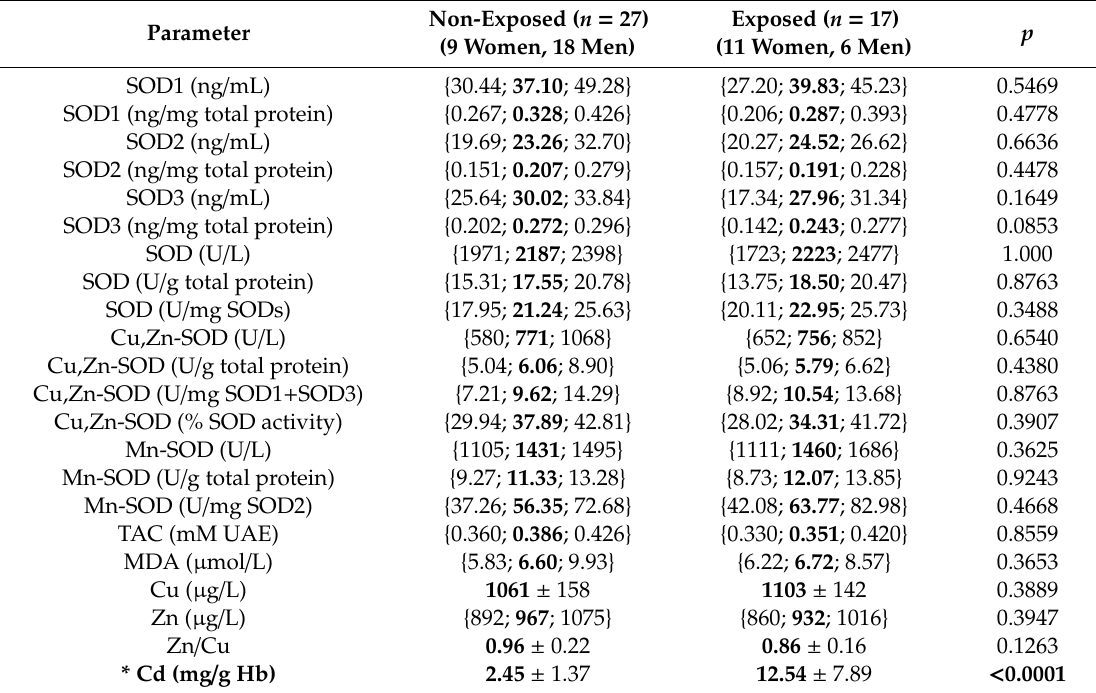
Table 5. Values of selected pro- and antioxidative parameters, and concentration of selected metals, in context of exposition to cigarette smoke, in obese